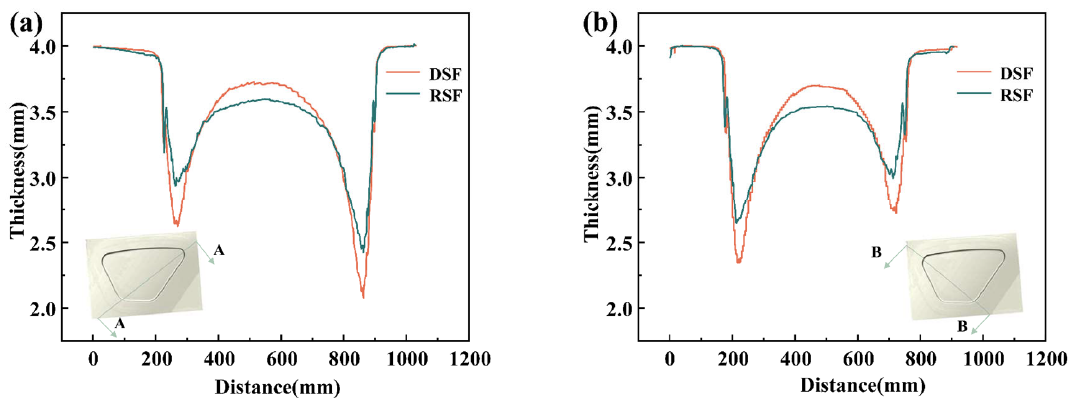
Figure 7. Thickness distribution on lines at the center of the fillets ( a ) Section A; ( b ) Section B. Table 3. Energy spectral scan results.